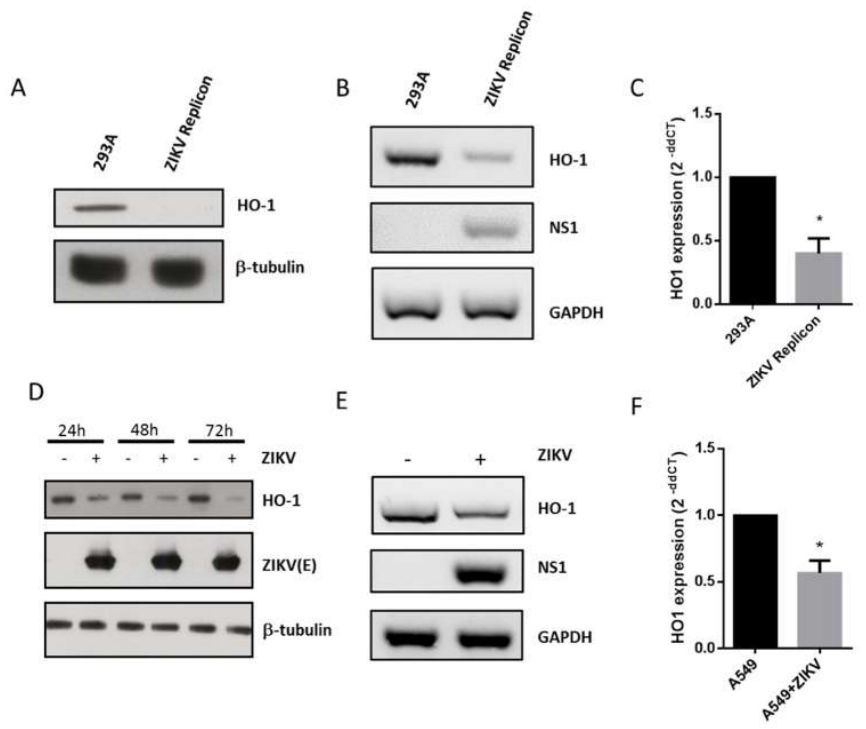
Figure 3. ZIKV replication and ZIKV infection decrease HO-1 protein and mRNA levels. ( A ) Western blot analysis of HO-1 protein expression in HEK 293A cells and ZIKV replicon cells using anti-HO-1. ( B ) RT-PCR analysis of HO-1, ZIKV NS1 and GAPDH mRNA expression in HEK 293A cells and ZIKV replicon cells. ( C ) RT-qPCR analysis of HO-1 expression in HEK 293A cells and ZIKV replicon cells. A549 cells were infected with ZIKV-PF13 at multiplicity of infection (MOI) of 5. In ( D ), HO-1 and ZIKV-E protein expression were analyzed by Western blot using anti-HO-1 and anti-ZIKV-E 4G2 antibody. Antibody against β -tubulin served as protein loading control. In ( E ), HO-1, ZIKV NS1 and GAPDH mRNA expression were analyzed by RT-PCR 24-h post infection. In ( F ) RT-qPCR analysis of HO-1 expression in A549 cells infected with ZIKV-PF13 24-h post-infection. * p < 0.05.